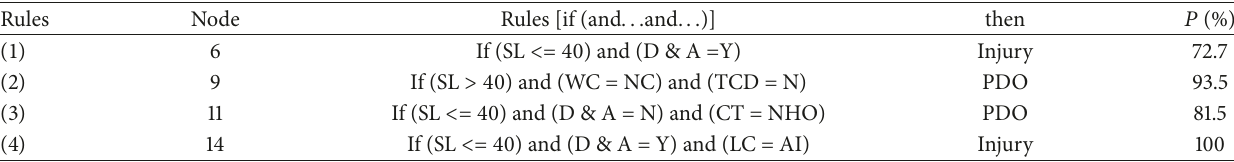
Table 4: Decision rules for crash severity of dark-not-lighted condition.